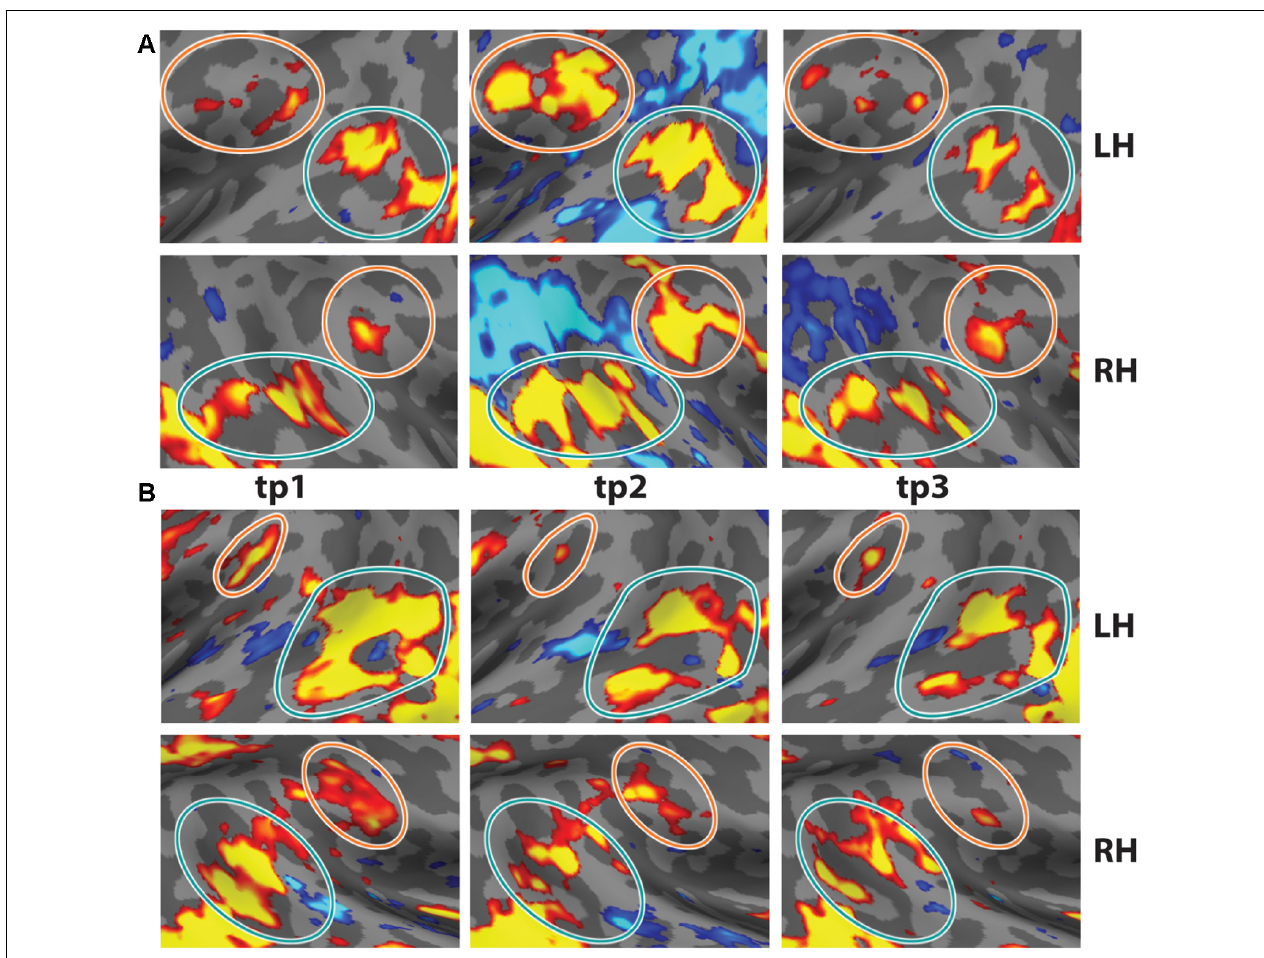
FIGURE 4 | Test-Retest of oddball contrast in two individual subjects. Two subjects were scanned on the task three times. (A) Data from s01 at t = 0, t = 7 months, and t = 19 months. (B) Data from s02 at t = 0, t = 5 months, and t = 11 months ( p < 0.01, uncorrected). Note the consistency across time in the anatomical locations. Data from tp1 reflects four runs of the